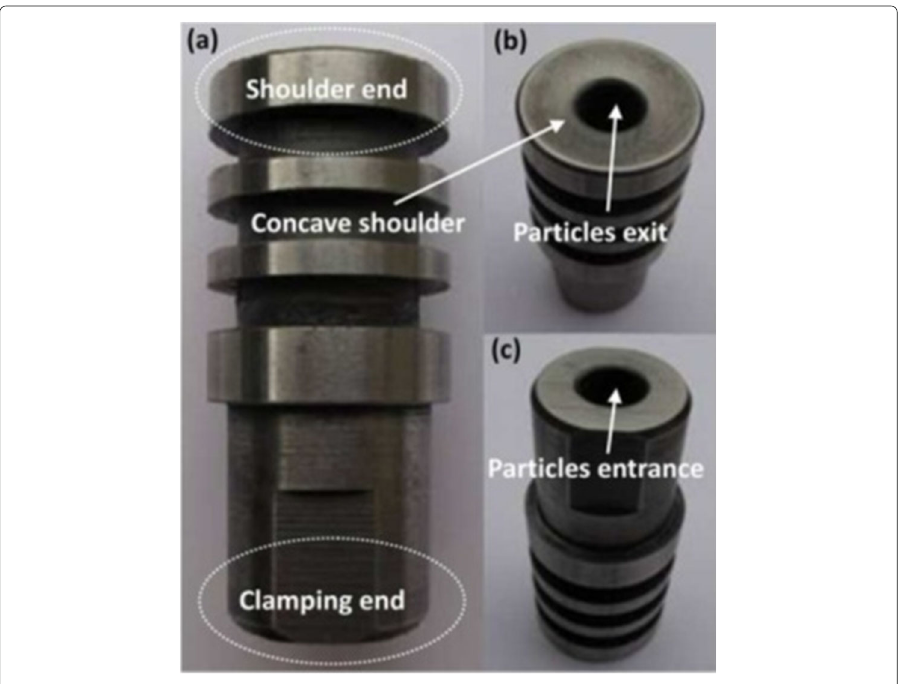
Fig. 12 Images of DFSP tool: a front view, b shoulder view, and c the clamping end